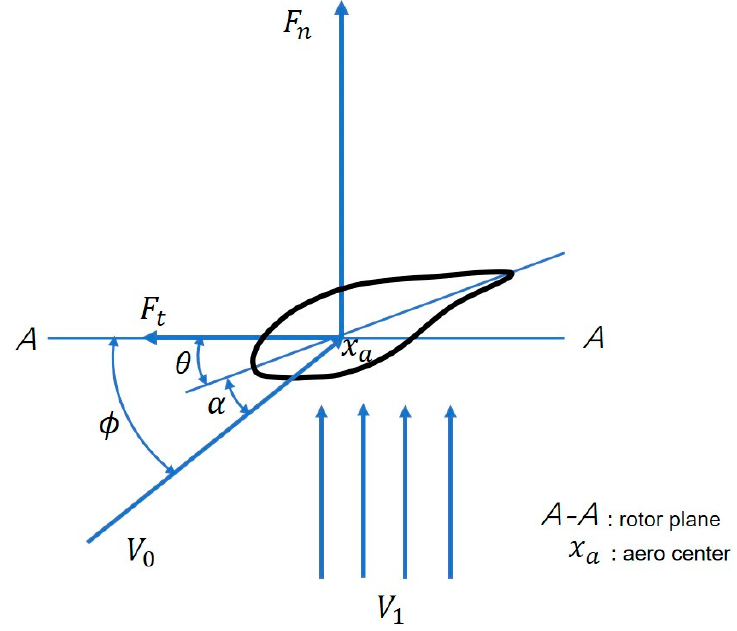
Figure 1. Aerodynamic forces acting on a blade section.